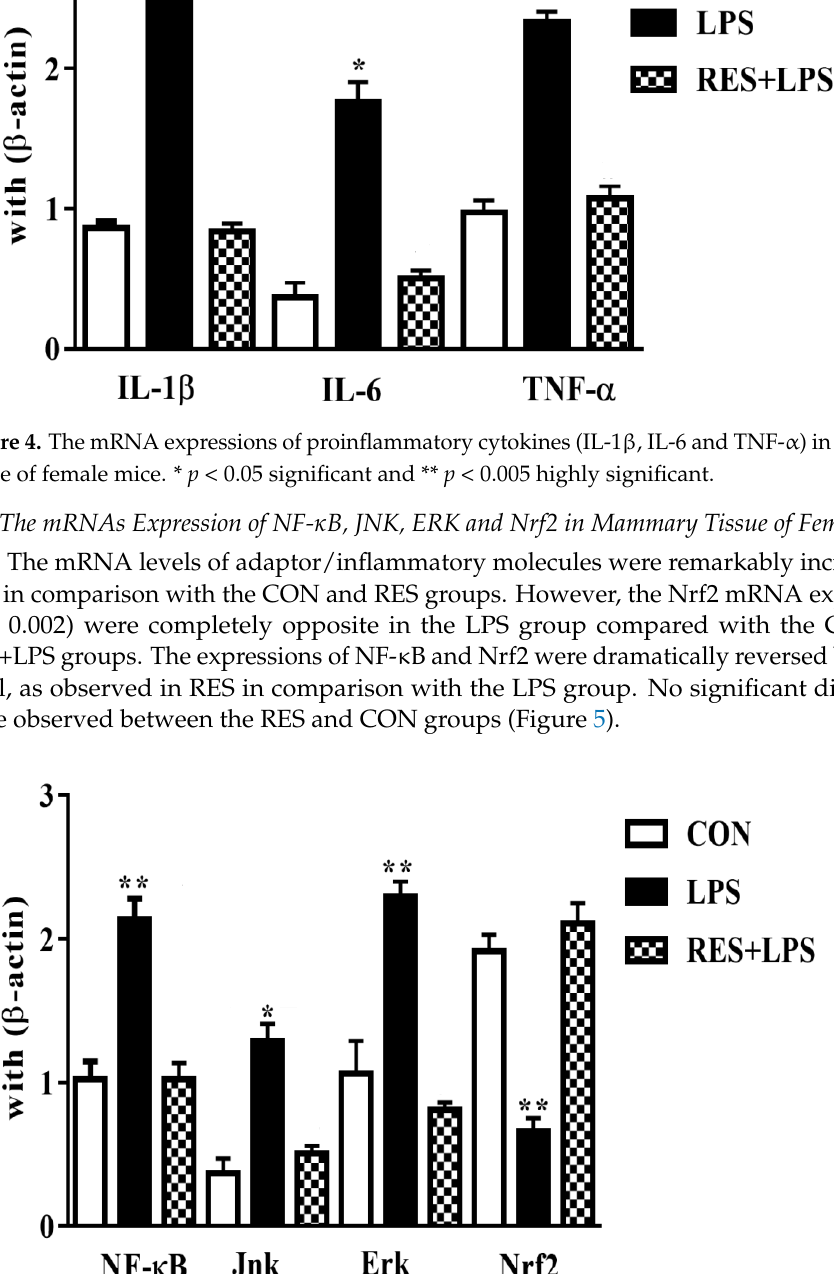
Figure 6. ( A ) Immunoblots and ( B ) quantification of pP65 and P65 in LPS in comparison with CON and RES+LPS groups. * p < 0.05 significant and ** p < 0.005 highly significant 4. Discussion Lipopolysaccharide (LPS), a substance found in the outer membranes of Gram-negative bacteria, triggers several significant cellular reactions that are vital to the pathophysiology of inflammatory responses. An immediate inflammatory response to pathogens may result from LPS. As bacterial LPS causes a variety of cell types to generate inflammatory cytokines, including IL 6 and IL 1, it has been widely employed to create an inflammatory model. [31]. It has been observed that ROS plays a dynamic role in mastitis